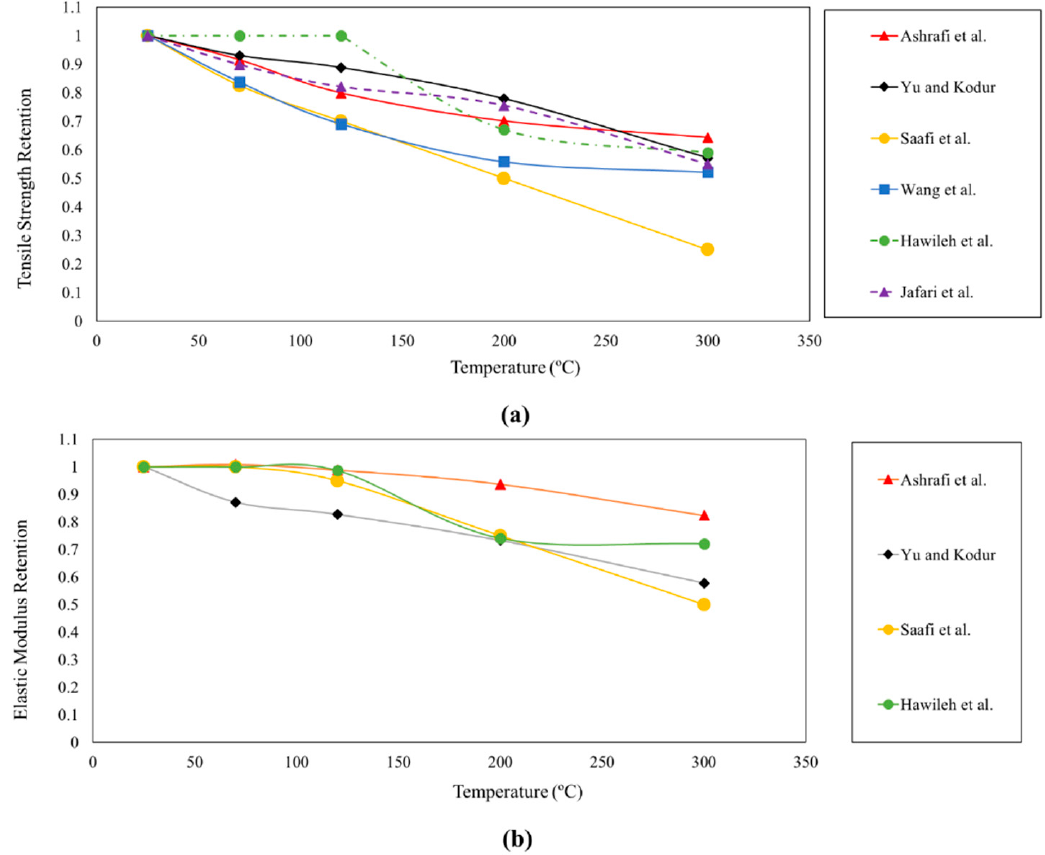
Figure 7. Comparison of predicting models: ( a ) tensile strength retention vs. temperature; and ( b ) tensile elastic modulus vs. temperature.